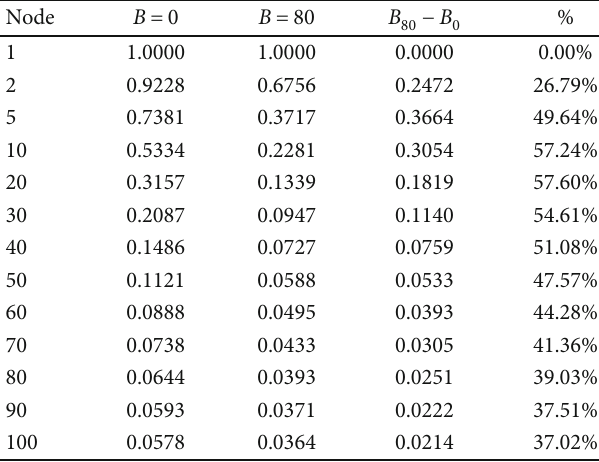
Table 4: Comparison of radiation values B = 80 .